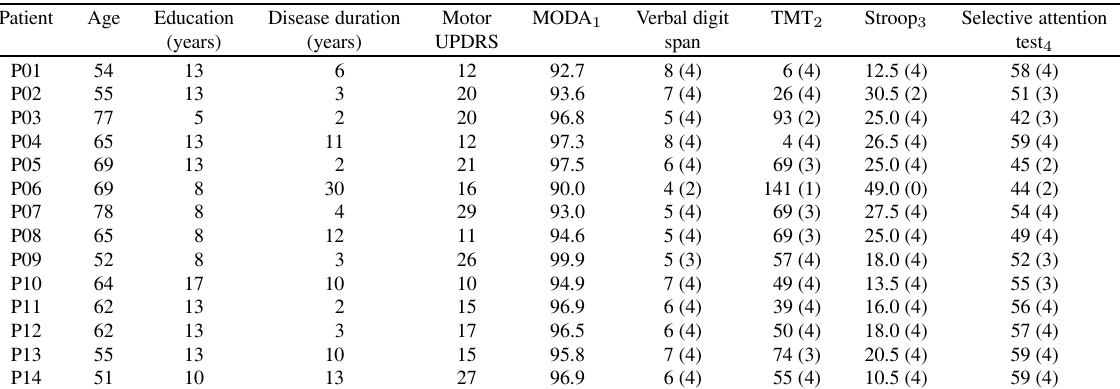
Table 1 Characteristics of patients group and results of cognitive tests